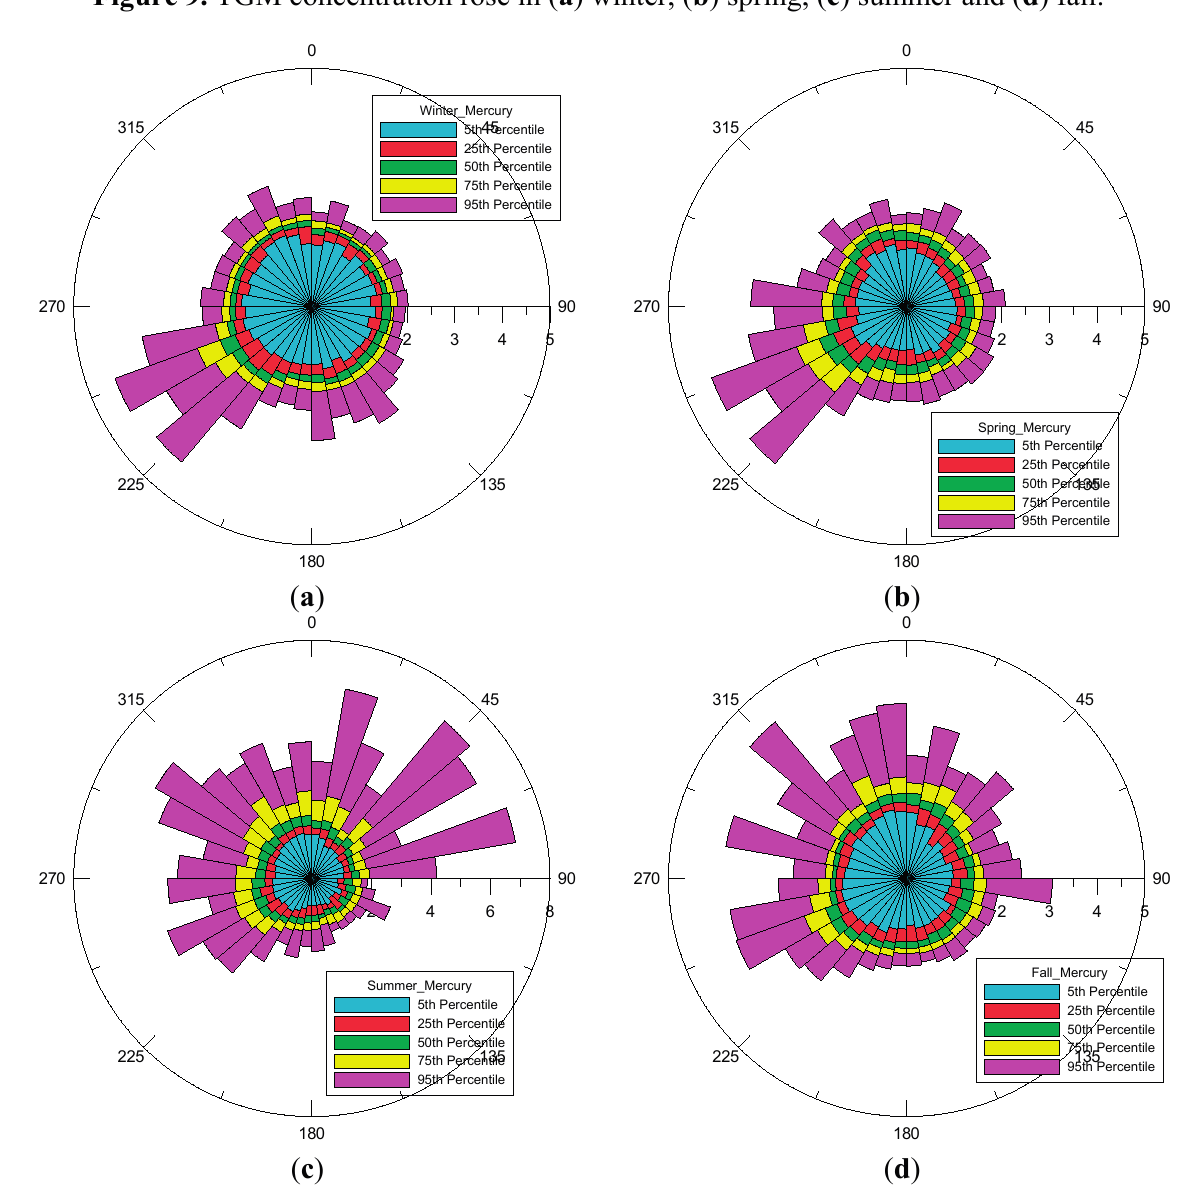
Figure 9. TGM concentration rose in ( a ) winter, ( b ) spring, ( c ) summer and ( d )